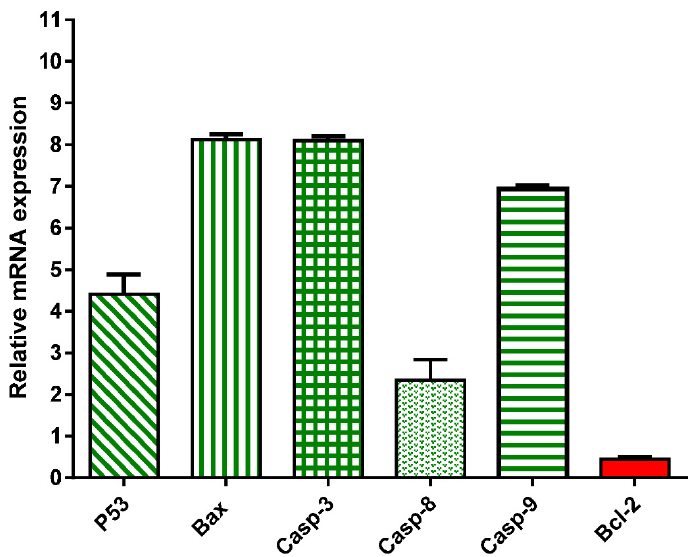
Figure 3. mRNA gene expression analysis of untreated and treated A549 cells with A. judaica ethanolic extract (IC 50 of 14.07 µ g/mL, 48 h). Fold of change of untreated control = 1.